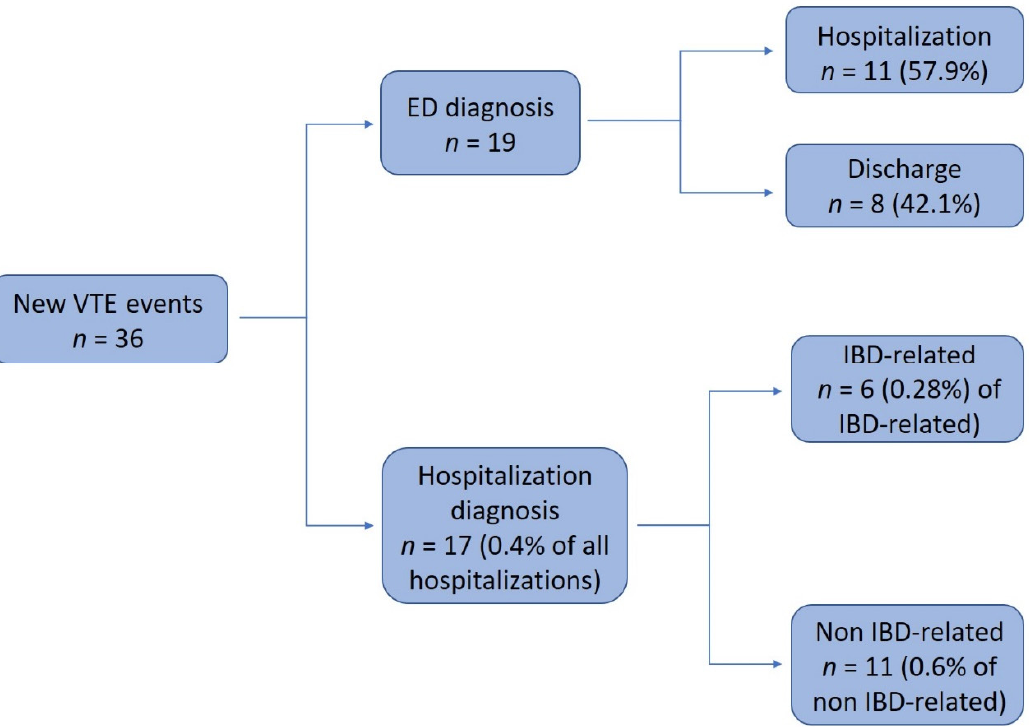
Figure 3. Newly diagnosed VTEs and their distribution between an ED vs. hospitalization diagnosis.